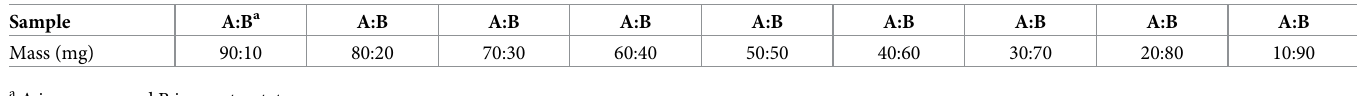
Table 2. Artificially simulate the adulteration of cassava starch in sweet potato starch. Sample